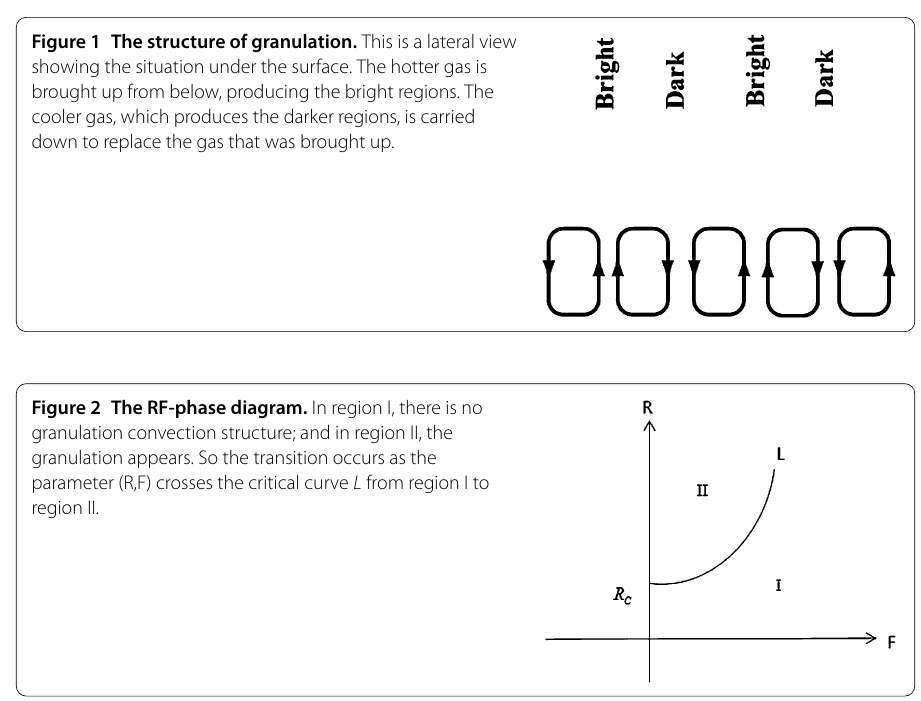
Figure 1 The structure of granulation. This is a lateral view showing the situation under the surface. The hotter gas is brought up from below, producing the bright regions. The cooler gas, which produces the darker regions, is carried down to replace the gas that was brought up.